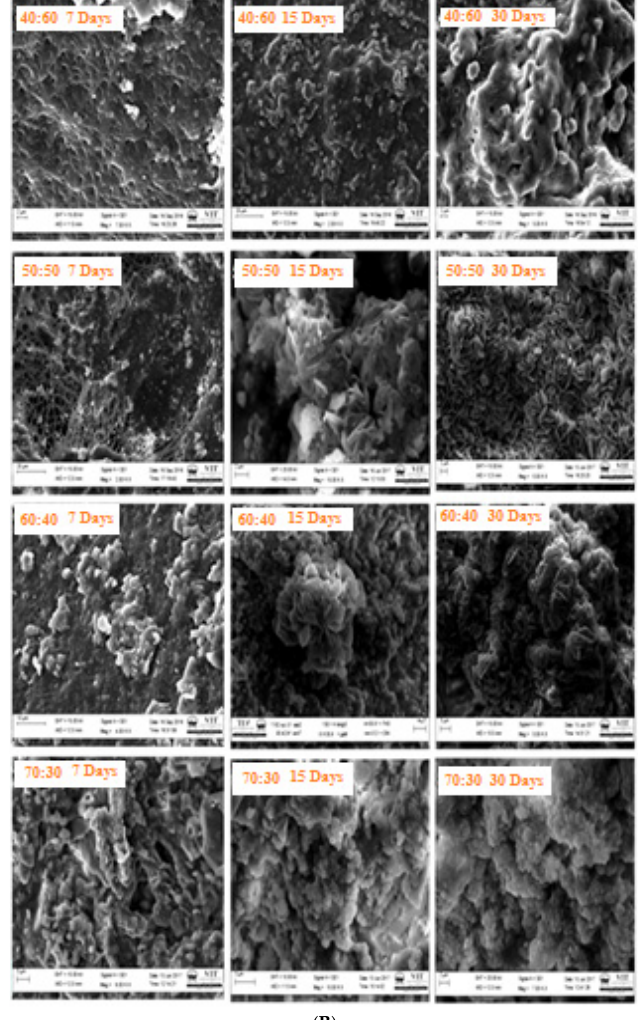
Figure 5. ( A ) SEM Morphology of electrospun nanofibers at various magnifications and fiber diam- eter (Insert) of various compositions . ( B ) SEM Morphology of SBF immersed electrospun nanofibers for various time intervals by in vitro bioactivity study.